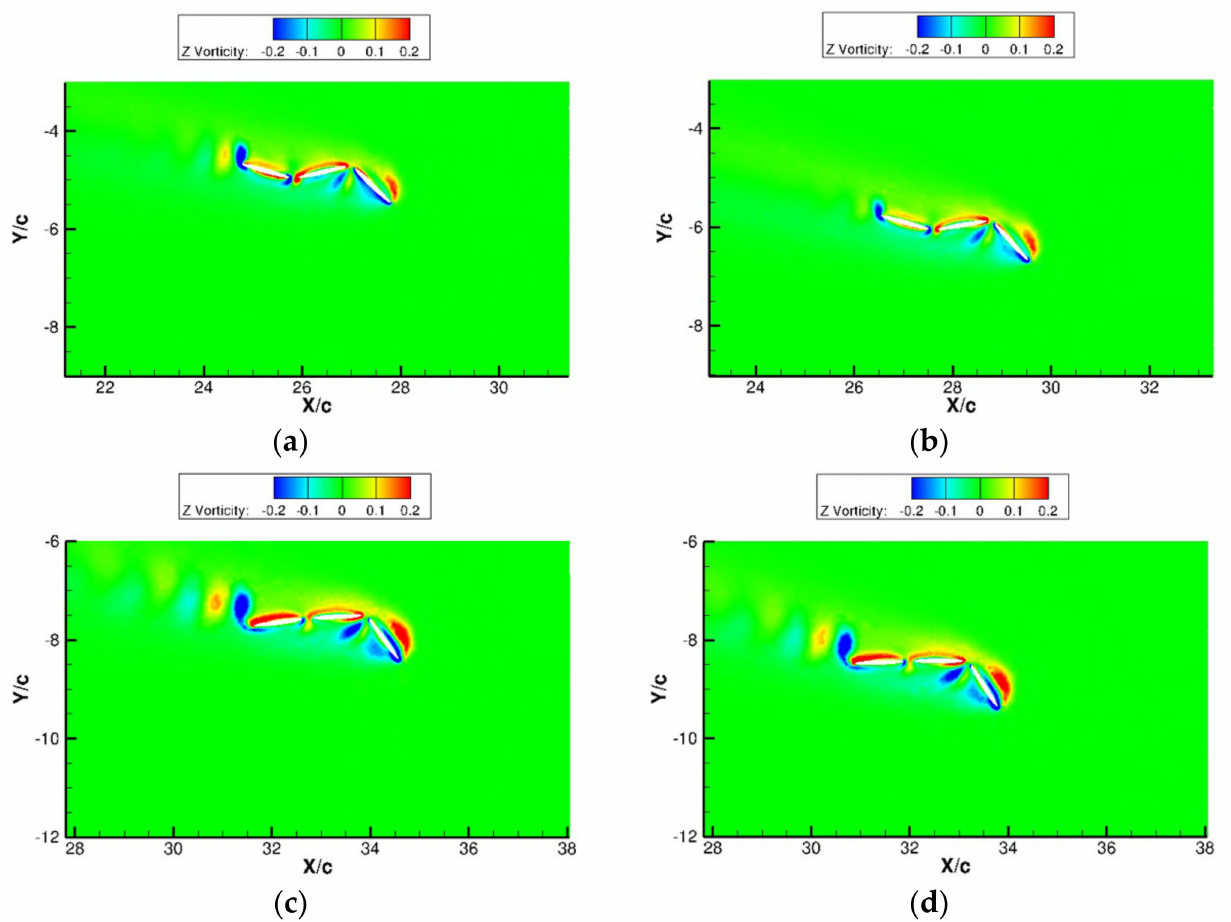
Figure 14. Vorticity contour of cases with ( a ) K = 1.97, R = 0, ( b ) K = 1.97, R = 0.245, ( c ) K = 11.05, R = 0 and ( d ) K = 11.05, R = 0.245 at time instant t / T =